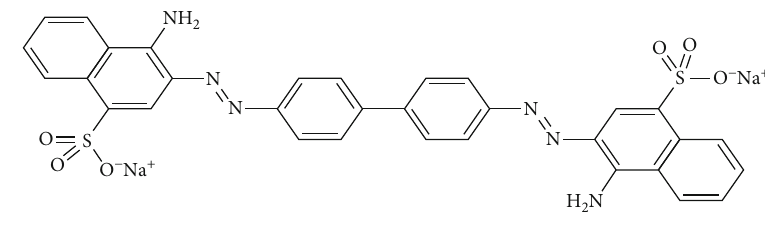
Figure 1: Chemical structure of Congo red dye.